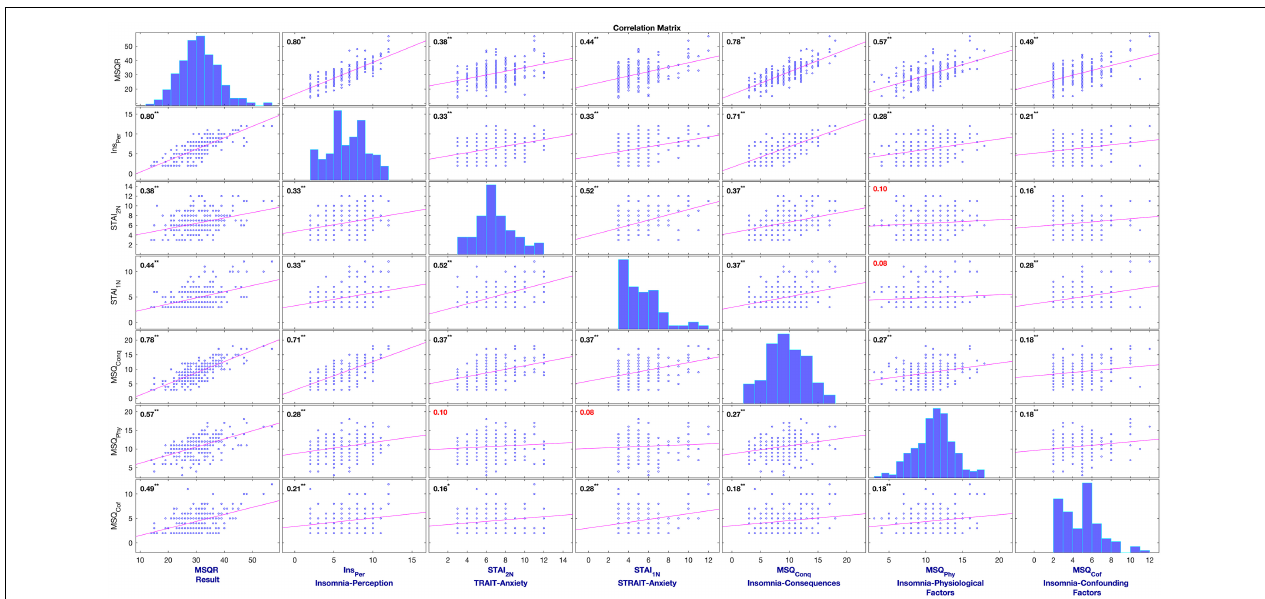
FIGURE 2 | Correlation Matrix of variables used in the multi-mediation model of insomnia to support CCF of insomnia.